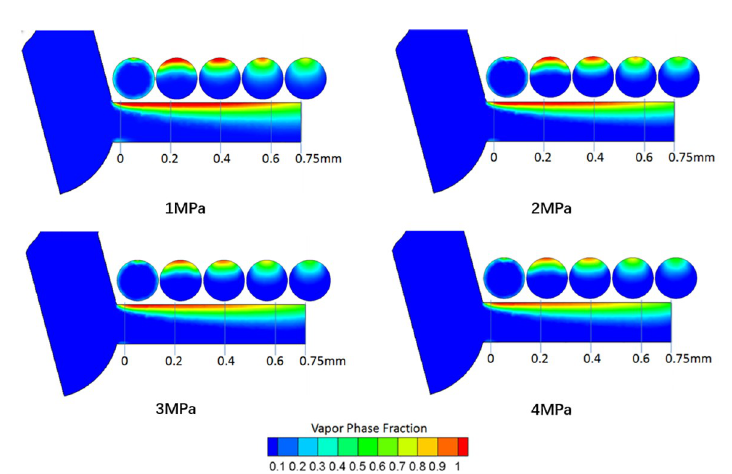
Fig 12. Contour of vapor volume fraction against different P